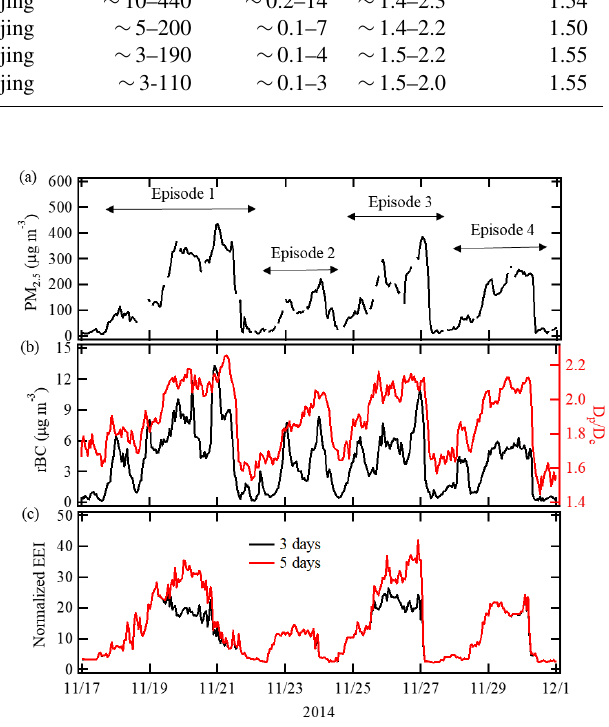
Table 1. The in situ measurement in this work. ( D p /D c ) 5% represents the average value of the lowest 5th percentile of the hourly D p /D c ratio for ambient BC-containing particles during the campaign period. Hourly PM 2 . 5 Hourly rBC Hourly Measurement Period Location (µgm − 3 ) (µgm − 3 ) D p /D c ( D p /D c ) 5% BJNOV2014